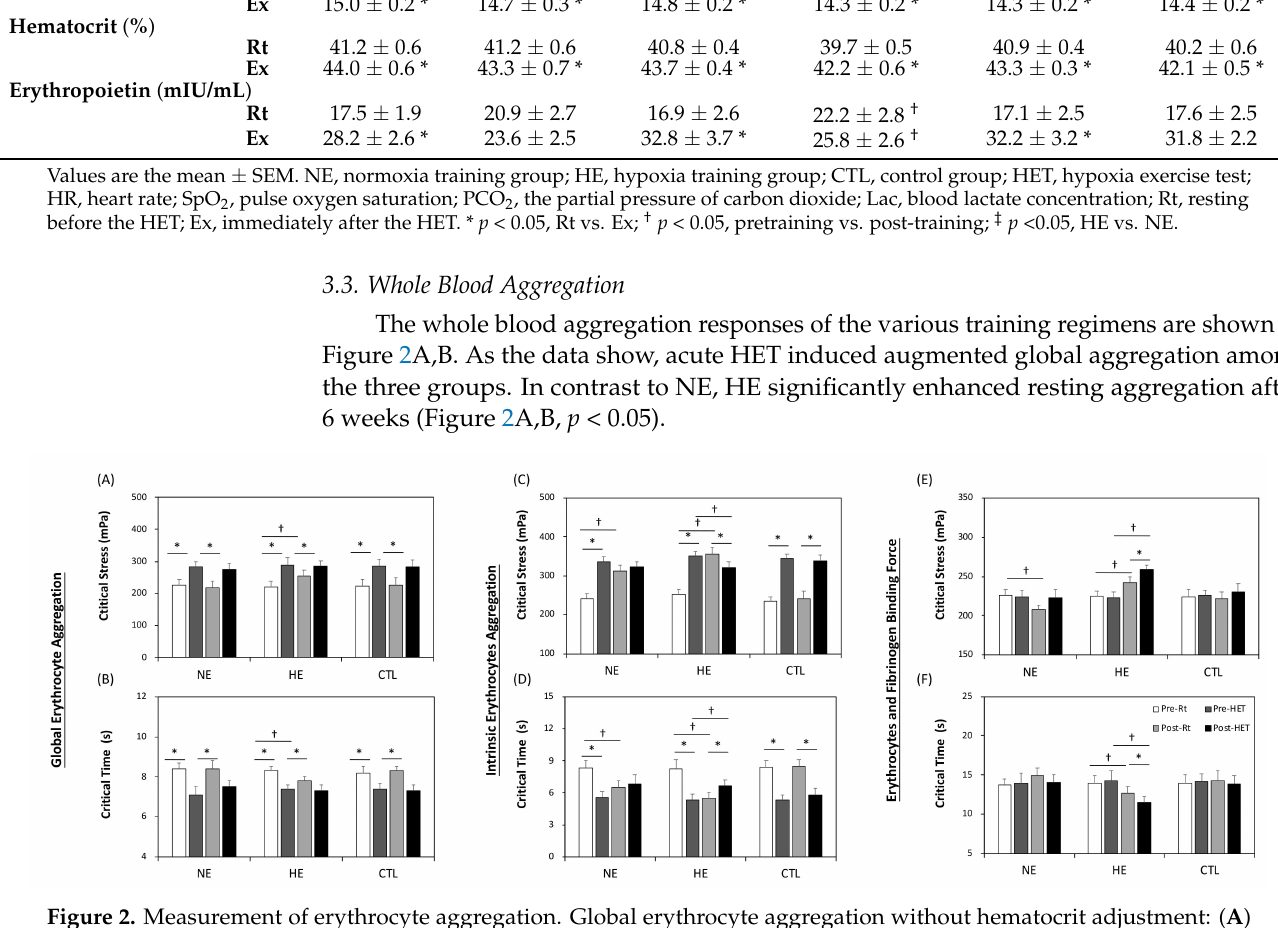
Figure 2. Measurement of erythrocyte aggregation. Global erythrocyte aggregation without hematocrit adjustment: ( A ) critical stress; ( B ) critical time. The repulsive force between the negatively charged cells (an intrinsic factor): ( C ) critical stress; ( D ) critical time. Cell-to-cell aggregation induced by fibrinogen (an extrinsic factor): ( E ) critical stress; ( F ) critical time. NE, normoxia training group; HE, hypoxia training group; CTL, control group; Pre, pretraining; Post, post-training; Rt, at rest; HET, immediately after HET; * p < 0.05, Rt vs. HET; † p < 0.05, pre vs. post. Values are the mean ±